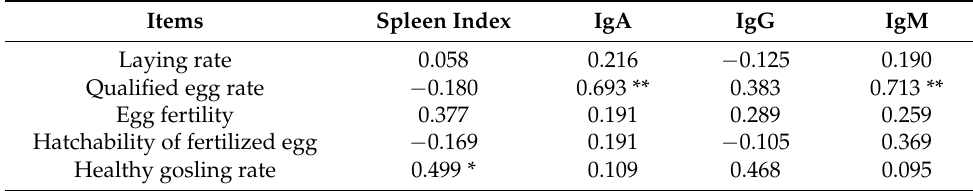
Table 11. Correlation analysis of reproductive performance index and immune index 1 . Items Spleen Index IgA IgG IgM Laying rate 0.058 0.216 − 0.125 0.190 Qualified egg rate − 0.180 0.693 ** 0.383 0.713 ** Egg fertility 0.377 0.191 0.289 0.259 Hatchability of fertilized egg − 0.169 0.191 −